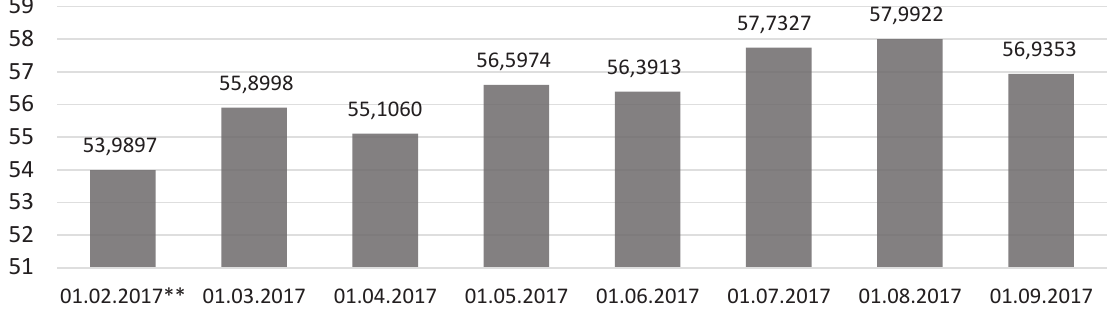
Figure 4. The share of non-working bank loans in 01.02.2017–01.09.2017 (in %)